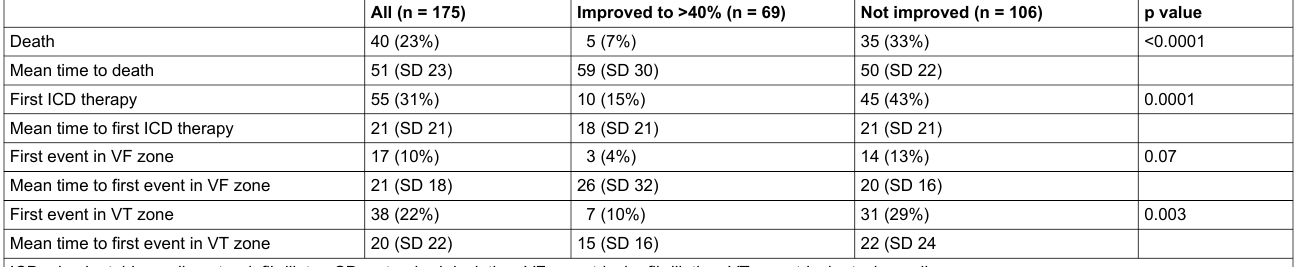
Table 2: Rates of deaths and appropriate ICD therapies and point in time of events (shown as months after implant). All (n =